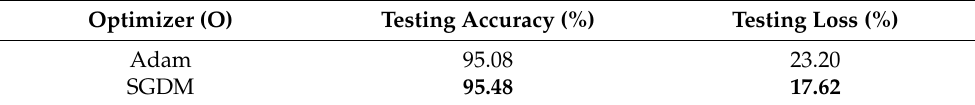
Table 4. Testing accuracy and loss of different optimizers (M = concat, B = 64).